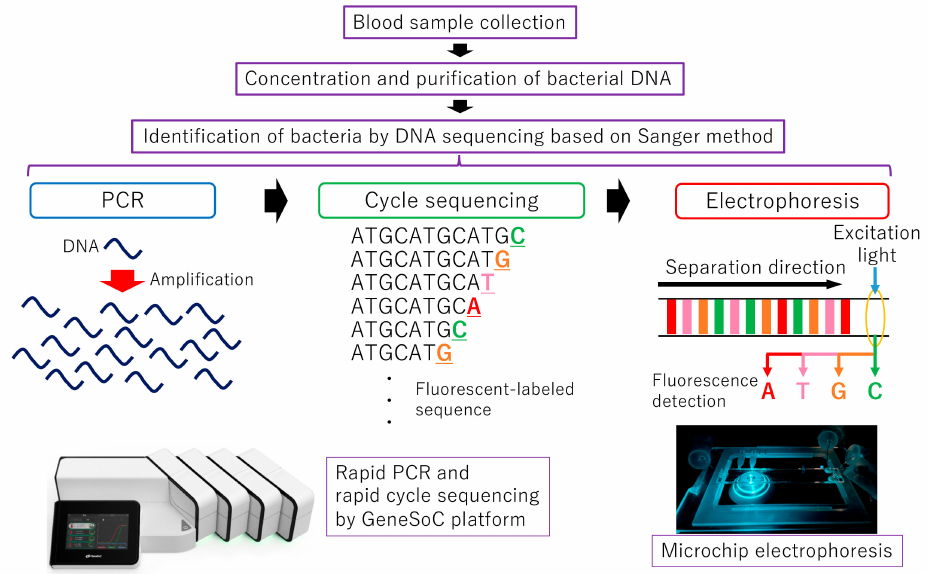
Figure 1. The clinical testing process and the whole experimental scheme for rapid DNA sequencing based on the Sanger